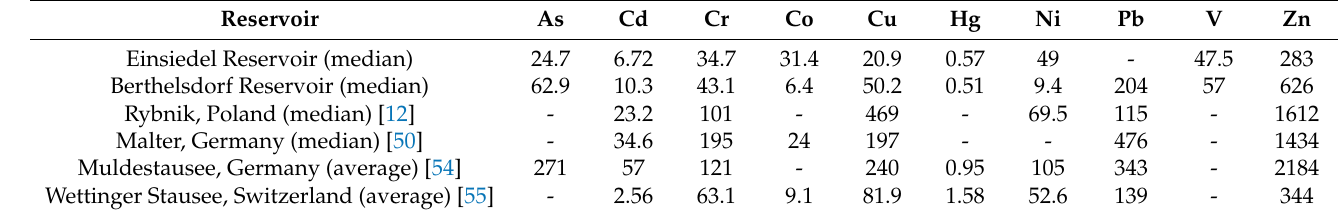
Table 8. Comparison of the metal(loid) concentrations (mg/kg) in the Einsiedel Reservoir and BSP sediments with metal(loid) concentrations (median and average values) in other reservoirs